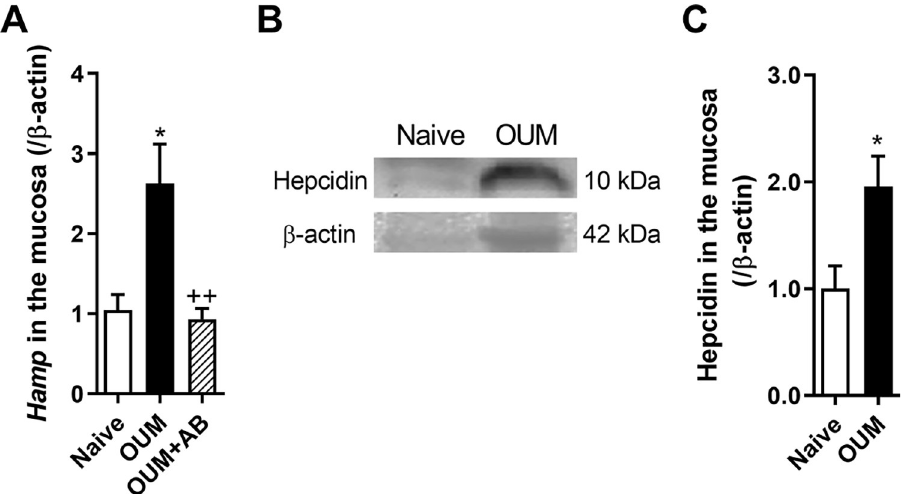
Fig 3. Changes in Hamp mRNA and hepcidin levels in oral mucosa in OUM model. All bars represent the mean ± SEM. (A) Relative expression of Hamp mRNA in the oral mucosa on day 2 in naive, acetic acid-treated oral ulcerative mucositis (OUM) and OUM with anti-bacterial pretreatment (AB) (n = 5 in each group). * p < 0.05 compared with naive Dunnett’s post hoc tests following one-way ANOVA. ++ p < 0.01 compared with OUM, Unpaired t-test. (B) Hepcidin in the oral mucosa on day 2 in naive and OUM. (C) The relative amount of hepcidin in the oral mucosa (n = 4 in each group). * p < 0.05 compared with naive. Unpaired t -test.